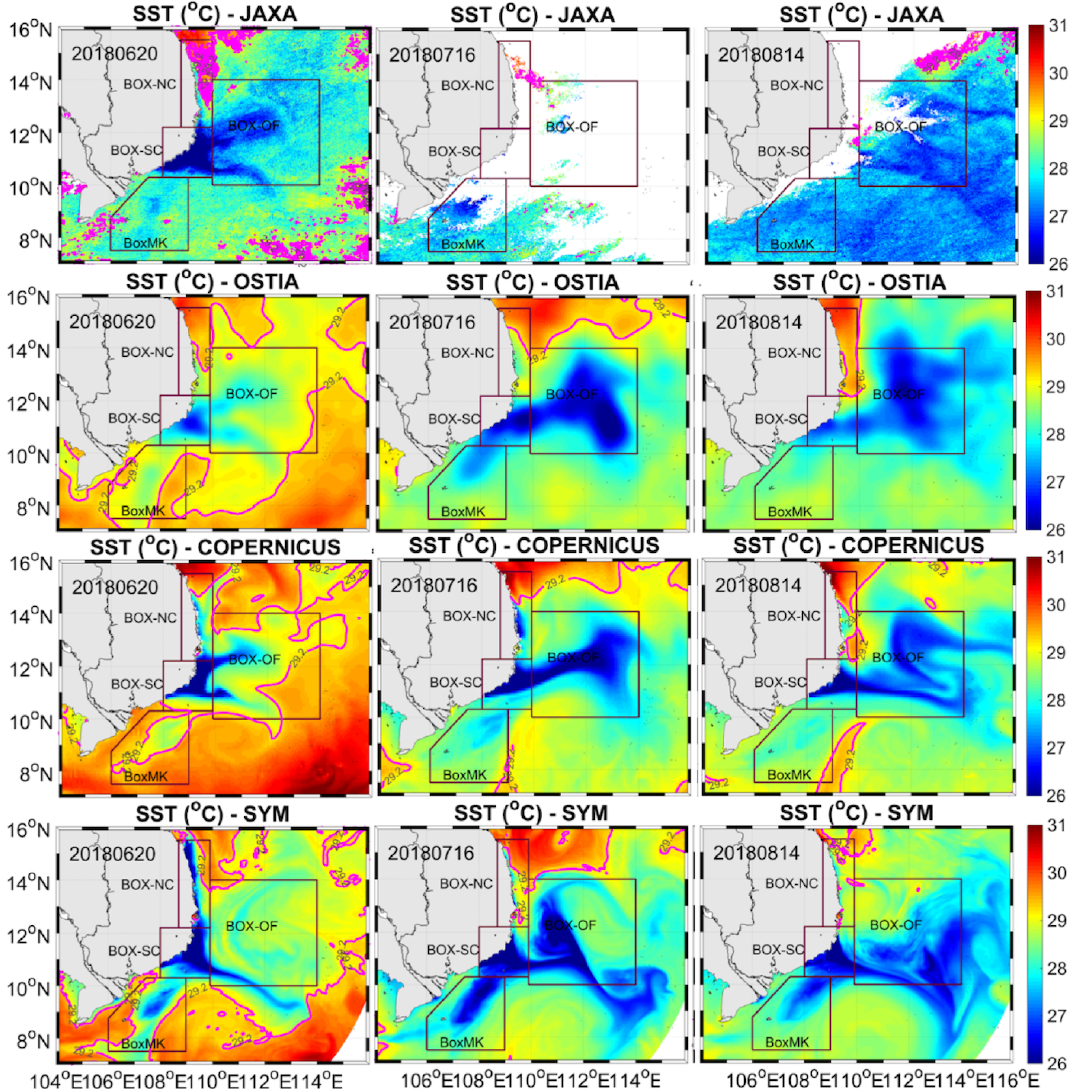
Figure 6. Daily SST ( ◦ C) on 20 June 2014 (left), 16 July 2014 (middle), and 14 August 2014 (right) from JAXA (first row), OSTIA (second row), COPERNICUS (third row), and SYMPHONIE (fourth row). The pink contour shows the isotherm T ref